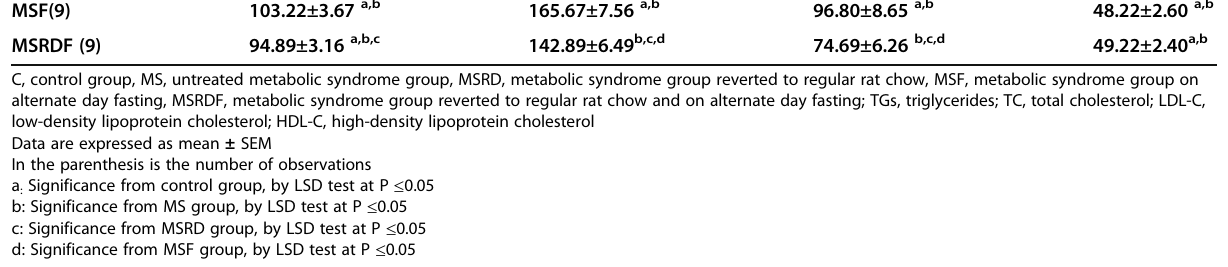
Table 4 The final lipid profile parameters in the five study groups TGs (mg/dl) TC (mg/dl) LDL-C (mg/dl)